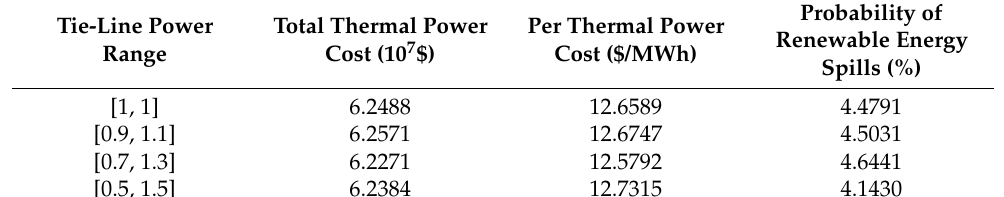
Table 5. Operation indices.